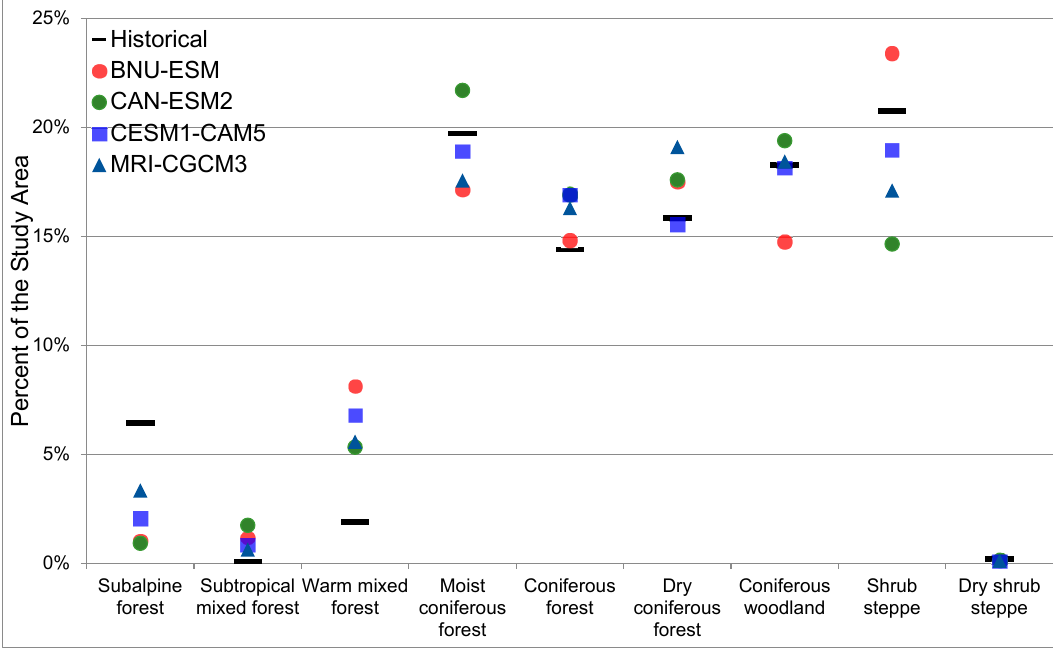
Figure 5. Percent of the study area that individual vegetation types cover for historical and four future projections for ( a ) midcentury (2035–2064) and ( b ) end of the century (2070–2099) under RCP 8.5. 3.2. Future Changes in Ecosystem Services Of the 78 species and resources analyzed, slightly more than half (40) may be vulnerable to climate change due to loss of habitat under the CESM1-CAM5 GCM. Within these 40 potentially vulnerable species and resources, over one third (14) were determined to have relatively large losses of potential habitat (Figure 6, Appendix Table B1), and consisted largely of mammals and birds that